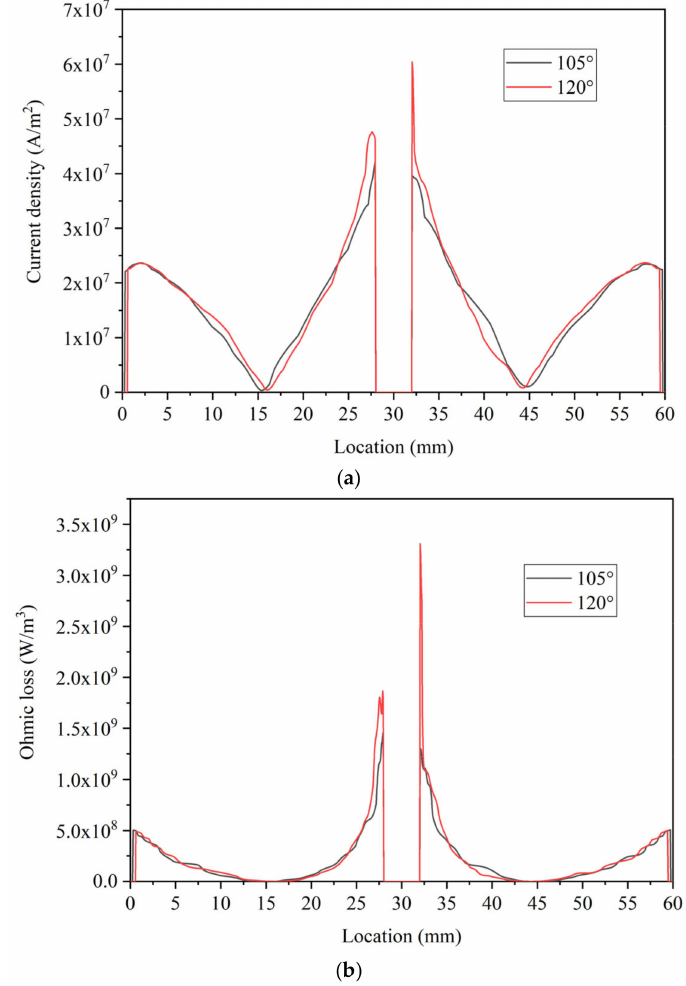
Figure 12. Current density and ohmic loss on the X − axis square line reference line: ( a ) current density change and ( b ) ohmic loss